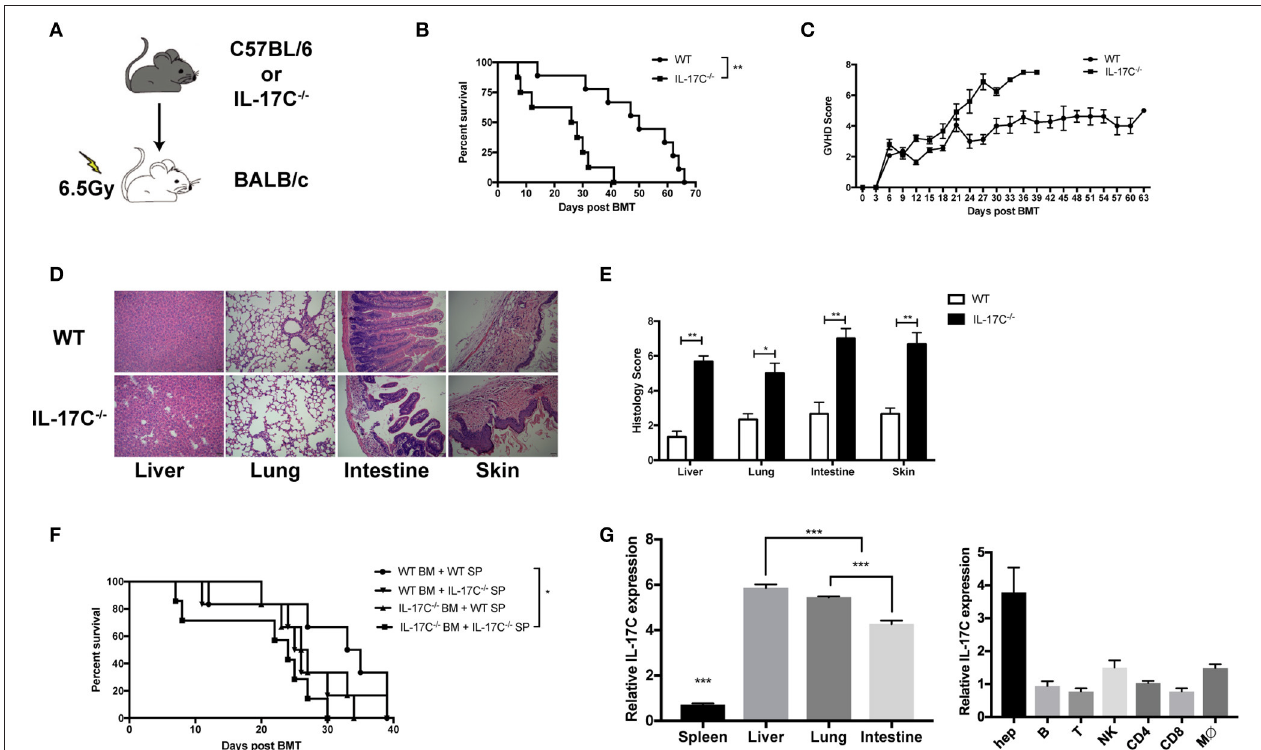
FIGURE 1 | IL-17C mitigates murine aGVHD after allo-HSCT. BALB/c recipients were lethally irradiated and transplanted with 1 × 10 ∧ 7 bone marrow cells and 5 × 10 ∧ 6 splenocytes from B6 WT or B6 IL-17C − / − mice respectively ( A–E ). ( A ) Schematic diagram of the experimental design; ( B ) aGVHD-related survival; ( C ) aGVHD clinical scores; ( D ) H&E staining; and ( E ) Histological analysis 14 days post-transplantation; ( F ) BALB/C recipients were transplanted with either B6 WT or IL-17C − / − allografts of splenocytes and bone marrow cells as indicated; n = 6–7 per group. Survival was monitored and compared by log-rank test; ( G ) RNA from aGVHD target tissues (left) or the indicated cell subsets (right) were extracted and reversed into cDNA 2 weeks post transplantation. IL-17C expression was detected by real-time PCR. Data are representative of at least three experiments and presented as mean ± SEM. * P < 0.05, ** P < 0.01, *** P < 0.001.